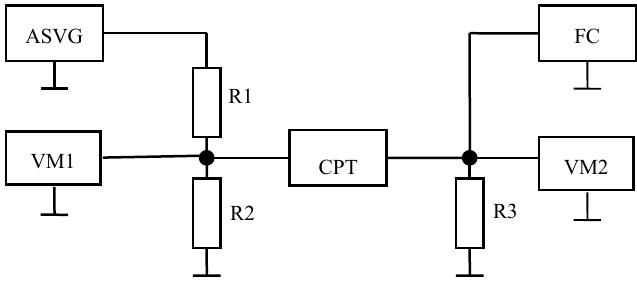
Fig. 6. Scheme for measuring CPT characteristics: ASVG – an adjustable sinusoidal voltage generator; VM1 – a voltmeter that registers the generator output voltage level; FC – a frequency counter; VM2 – a voltmeter that registers the level of the output